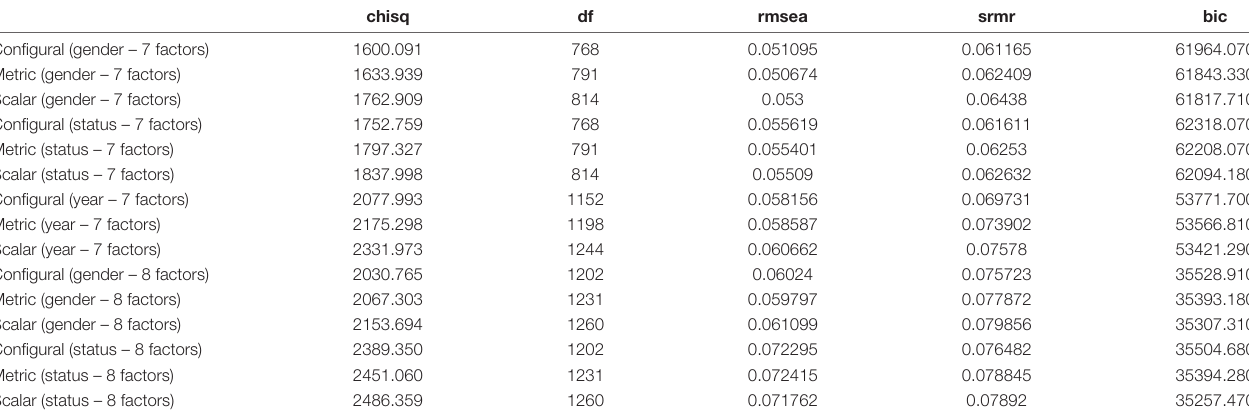
TABLE 4 | Fit indices for the assessment of measurement invariance. chisq df rmsea srmr